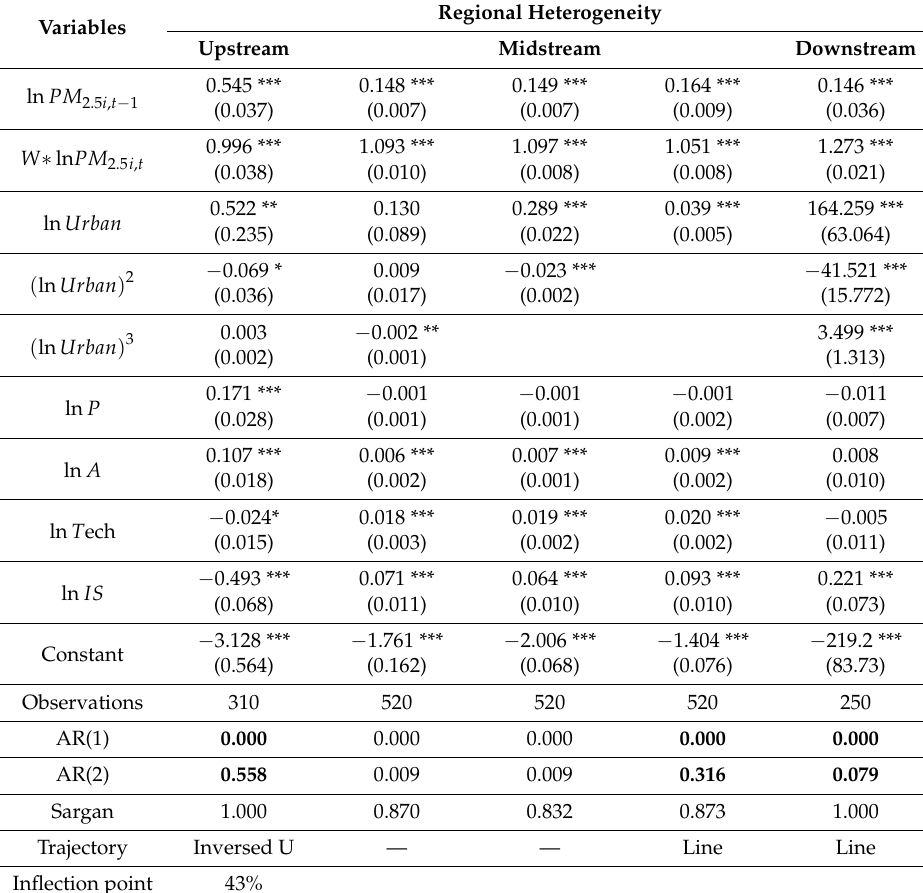
Table 4. Heterogeneity results by upstream, midstream, and downstream cities.